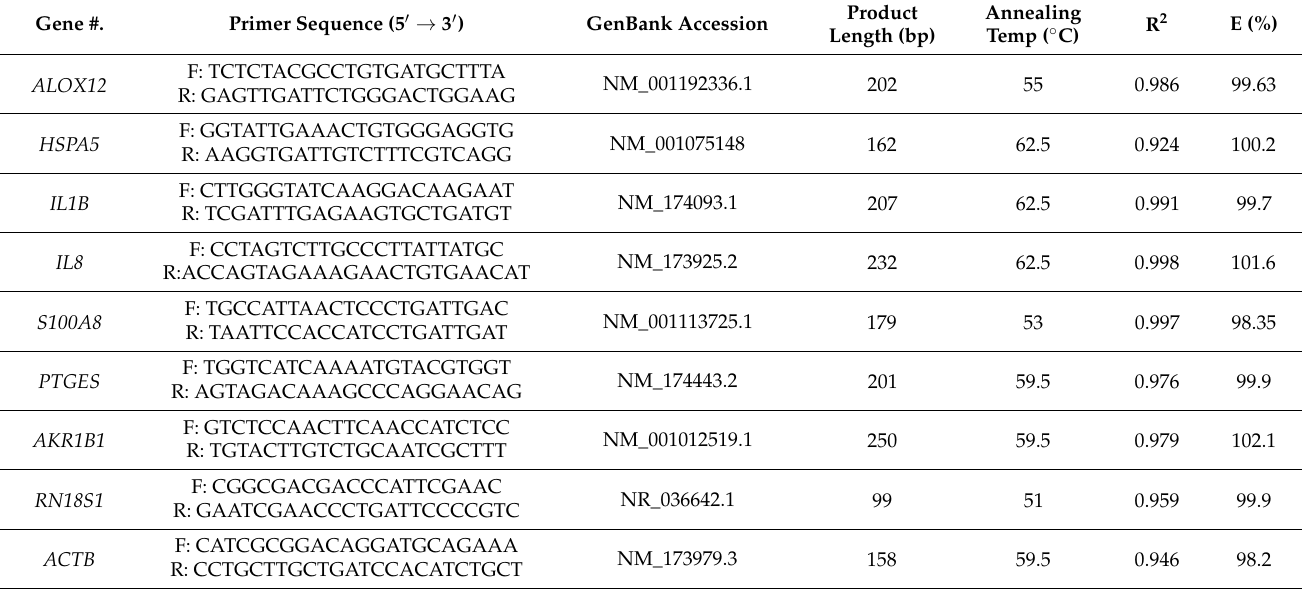
Table 1. Oligonucleotide primer sequences, GenBank accession, expected amplicon size, specific annealing temperature, plate read temperature, R 2 of the standard curve and efficiency of the assay (E) used for RT-PCR determination. All primers were finally accessed in May